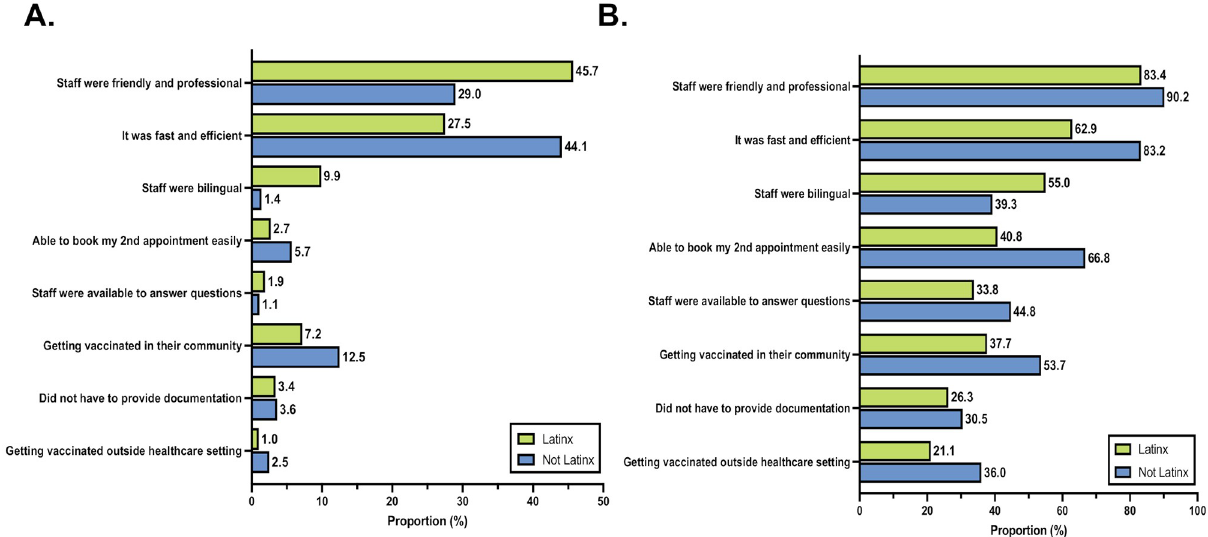
Fig 5. Features of the Unidos en Salud neighborhood vaccination site that clients said that they liked or appreciated stratified according to ethnicity. Panel A shows the features that clients liked the most (can choose only one) while Panel B shows all of the features that clients stated that they